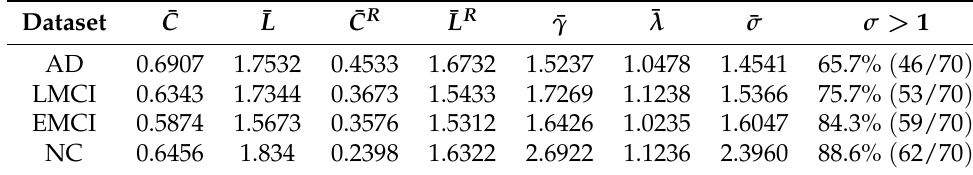
Table 5. Average small world